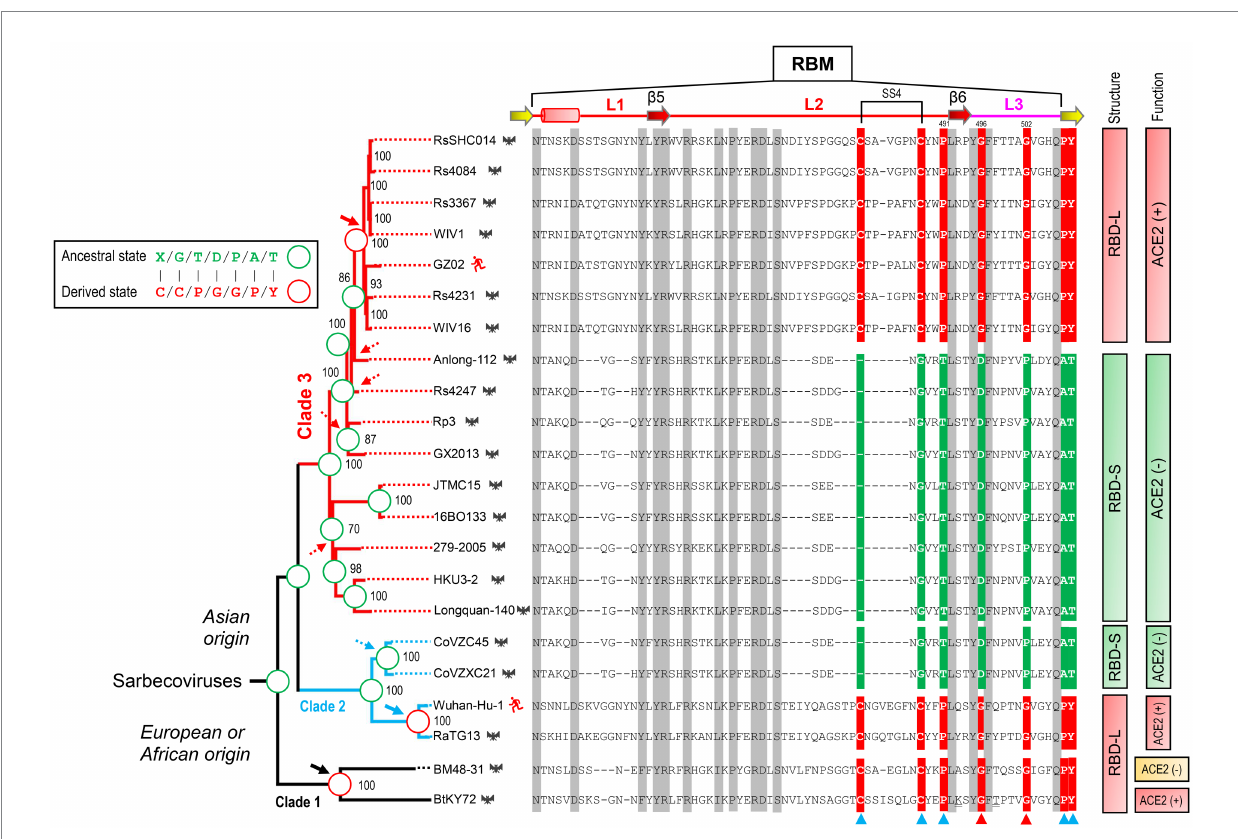
FIGURE 5 Evidence for parallel evolution of ACE2-binding RBMs in three Sarbecovirus clades. Phylogenetic relationships of SARS-CoV (strain GZ02), SARS-CoV-2 (Strain Wuhan-Hu-1) and SL-CoVs were reconstructed based on their whole genomes. The relationships were inferred by using the Maximum Likelihood method with the model GTR + G + I. The percentage of trees ( ≥ 70%) in which the associated taxa clustered together is shown at the nodes. Proposed insertion or deletion events are denoted by solid or dotted arrows. Right, sequence alignment of RBML1-3 with conservation across the alignment shaded in grey and the determinants for the topology of RBD-based trees in Figure 2B indicated by triangles, in which two directly associated with functional divergence via removing unfavorable interactions are shown in red. Sites involved in parallel substitutions are reconstructed for each nodes, in which the same ancestral amino acids are indicated by green circles and the same derived amino acids evolved through independent changes by red circles. “X” denotes a deficient residue. Structure-and function-based classifications are shown on the right of the alignment: ACE2 (+): RBDs capable of binding ACE2; ACE2 ( − ): RBDs incapable of binding ACE2 (Ren et al., 2008; Hu et al., 2017, 2018; Letko et al., 2020; Roelle et al., 2022; Starr et al.,